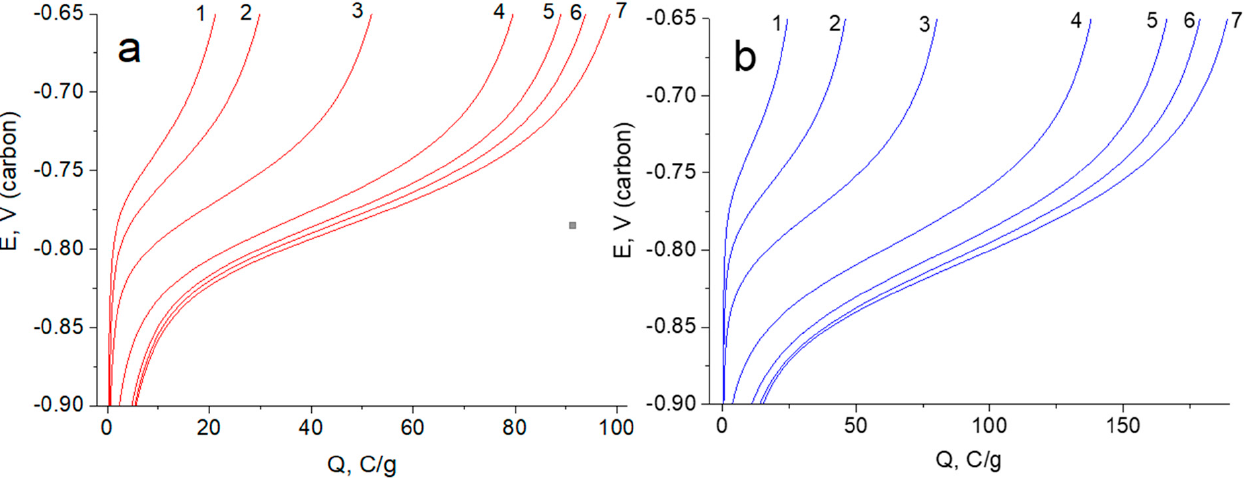
Figure 9. Galvanostatic charging curves of rGO/TiO 2 15% ( a ), rGO/TiO 2 30% ( b ) and composites, which were obtained at discharging current of 240 mA/g for different time of potentiostatic charging at − 1.2 V: 1—5 s; 2—10 s; 3—20 s; 4—50 s; 5—100 s; 6—200 s; 7—500 s.